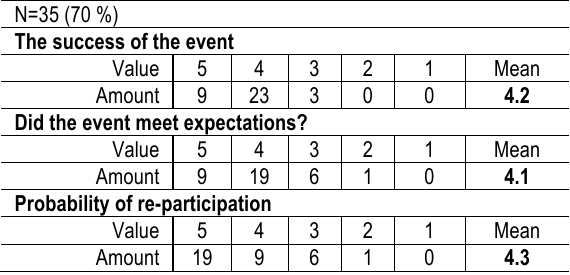
Table 1. Summary of the feedback based on the